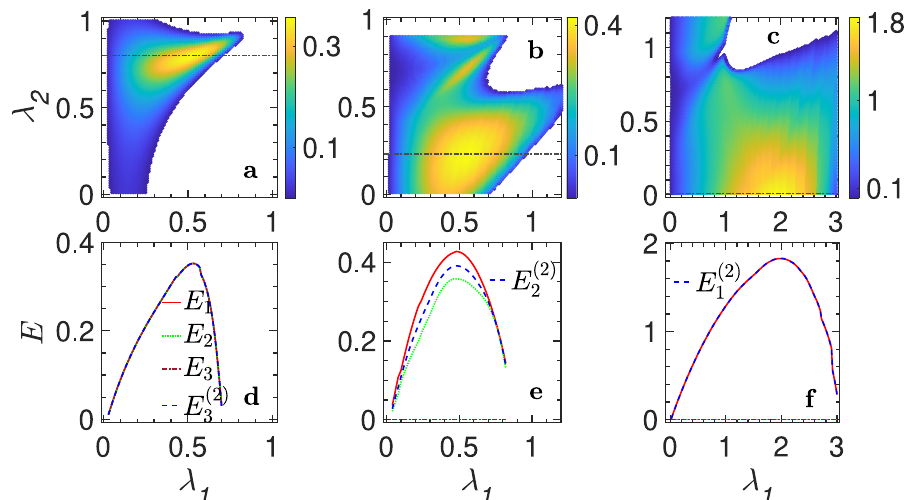
Fig. 3 Logarithmic negativity quantifying dyadic entanglement. Panels a – c show numerically optimized entanglement as a function of the ¼ 1 þ λ 2 (cid:2) λ 2 Bogoliubov coef fi cients λ 1,2 (note that λ 2 due to normalization). We plot entanglement in a all pairs, E ð 2 Þ 3 1 2 c one pair, E ð 2 Þ . Cuts along the black dot-dashed lines through the maximum entanglement are shown in panels d – f (dashed blue line) 1 together with entanglement in individual pairs (solid red line for E 1 , dotted green line for E 2 , and dot-dashed maroon line for E 3 ); note that E 3 = 0 in e and f , and E 2 = 0 in f . The plots show entanglement in d three pairs for λ 2 = 0.8, e two pairs for λ 2 = 0.23, and f one pair for λ 2 = 0.01. We assume the mechanical quality factor Q = ω m / γ = 5 × 10 9 and mean thermal occupation of n ¼ 2 ´ 10 7 equal for all mechanical modes and linewidth for all cavity modes κ = 0.4 ω m . For numerical optimization, the maximum coupling rates are set at G k = 0.4 ω m